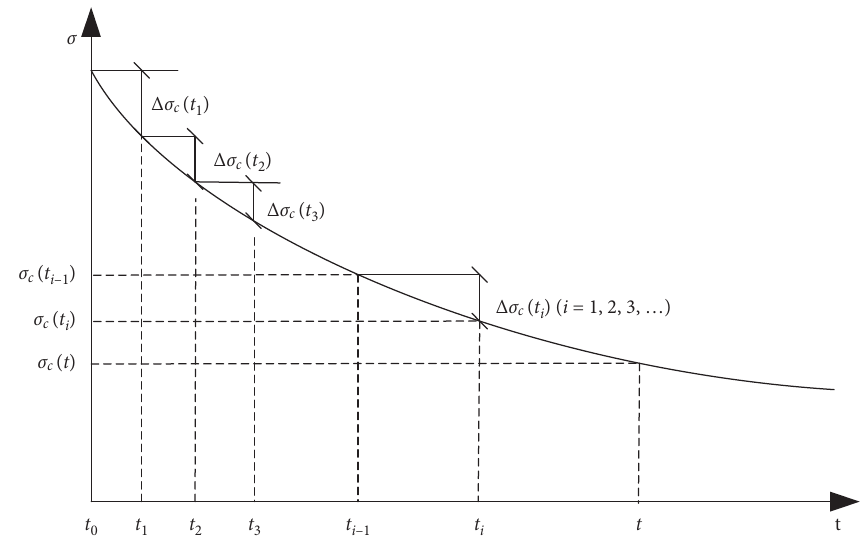
Figure 8: Stress and time intervals for the step-by-step